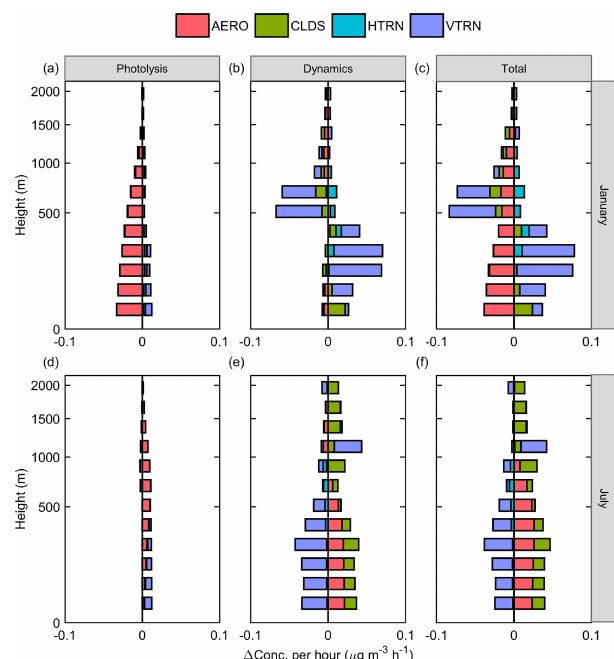
Figure 5. Vertical distribution of the responses of the main process of sulfate to ADEs in the JJJ region at noontime in January (a, b, c) and July (d, e, f)